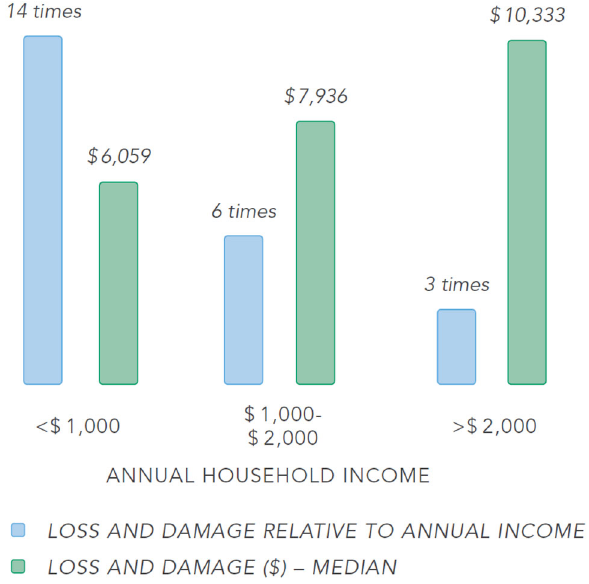
Fig. 7 Loss and damage in USD and as proportion of annual